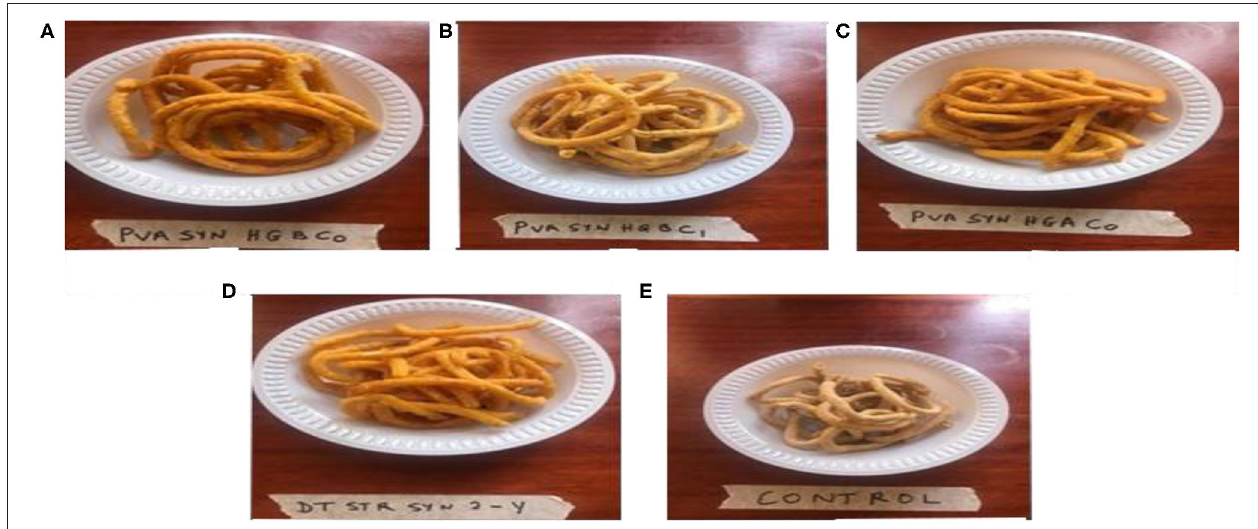
FIGURE 2 | Kokoro from three provitamin A maize genotype; (A) PVA SYN HGBC 0 (B) PVA SYN HGBC 1 (C) PVA SYN HGAC 0 (D) DT STR SYN2-Y (Control 1) (E) Commercially purchased Kokoro (Control